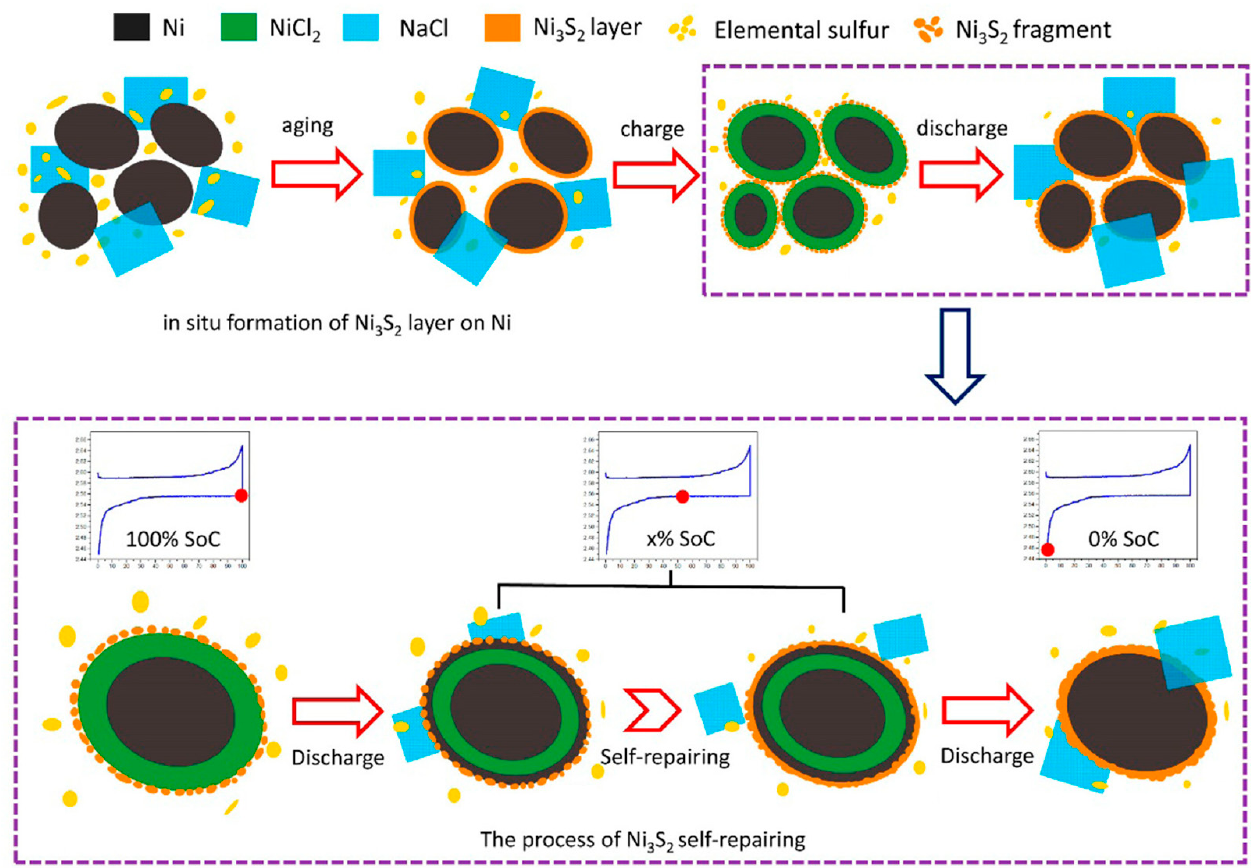
Figure 3. Schematic illustration of the Ni 3 S 2 layer self-repairing process and the proposed mechanism of sulfur additive via preventing Ni particle growth (adapted with the permission from ACS).